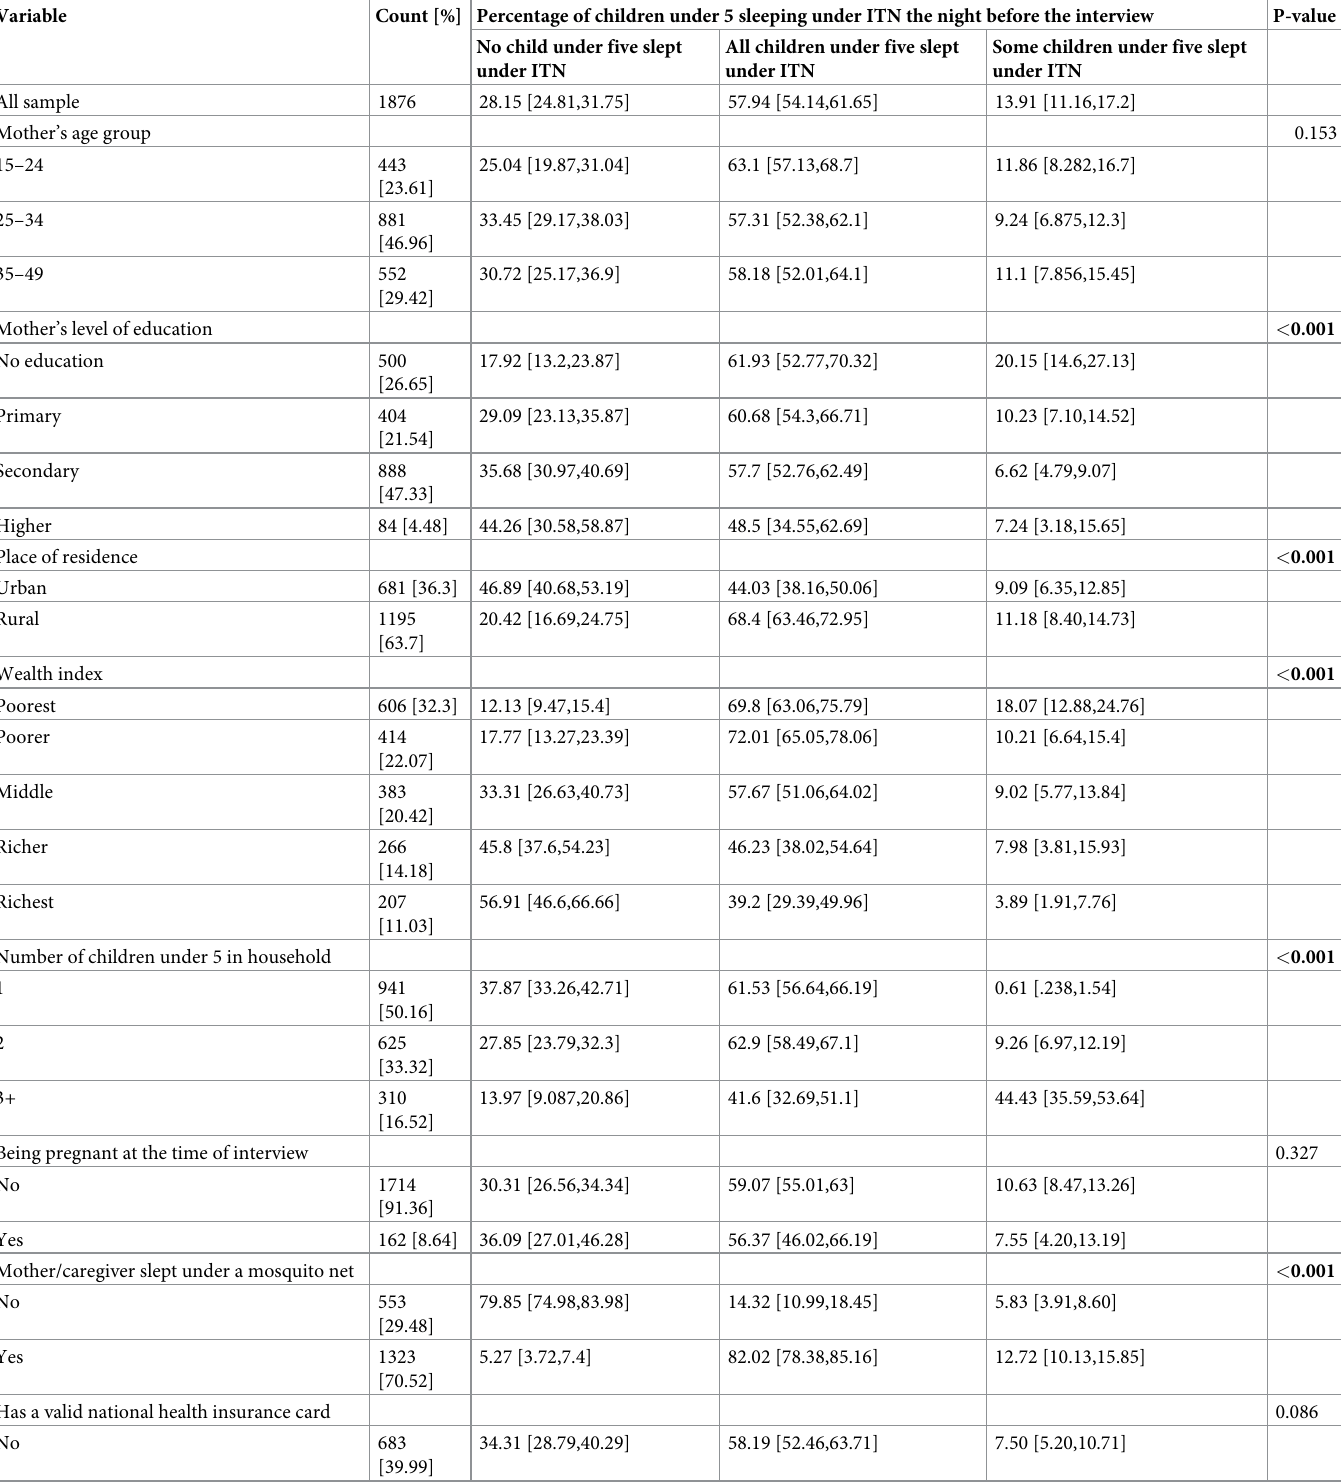
Table 1. The percentage of children under five sleeping under ITN by mothers’ background characteristics.